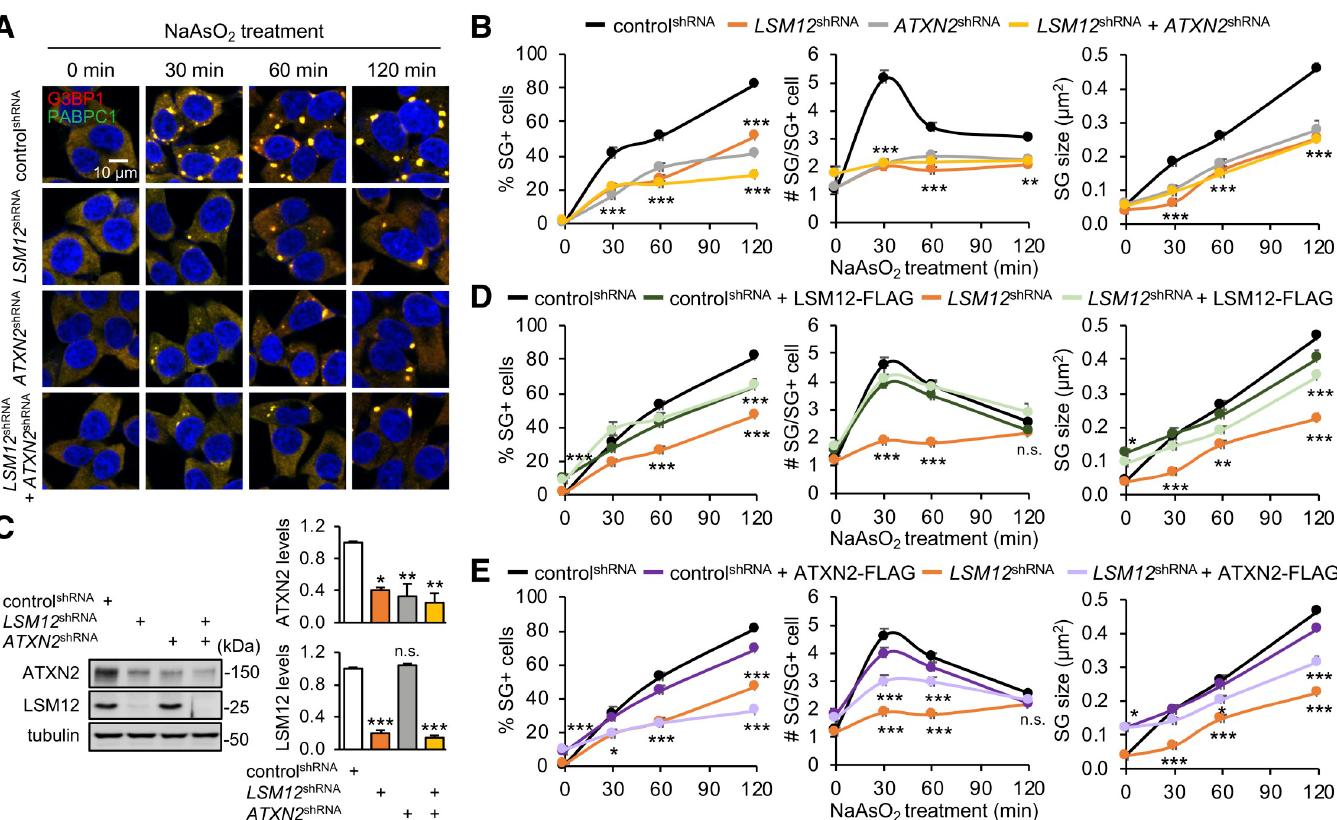
Fig 1. LSM12 depletion attenuates SG formation upon arsenite-induced oxidative stress. (A) LSM12 and ATXN2 promote arsenite-induced SG assembly, likely via the same genetic pathway. SH-SY5Y cells stably expressing each shRNA were incubated with 50- μ M sodium arsenite (NaAsO 2 ) for the indicated time and then co-stained with anti-G3BP1 antibody (red), anti-PABPC1 antibody (green), and Hoechst 33258 (blue) to visualize SGs and the nucleus, respectively. (B) The percentage of SG- positive cells, the number of SGs per SG-positive cell, and the size of SGs were quantified using ImageJ software and averaged ( n = 15–19 confocal images of random fields of interest obtained from 3 independent experiments; n = 329–1,045 cells). Error bars indicate SEM. �� P < 0.01, ��� P < 0.001 to control shRNA cells at a given time point, as determined by 2-way ANOVA with Tukey post hoc test. (C) Immunoblotting of total cell extracts from individual shRNA cell lines with anti-ATXN2, anti-LSM12, and anti-tubulin (loading control) antibodies. The abundance of each protein was quantified using ImageJ and normalized to that of tubulin. Relative protein levels were then calculated by normalizing to those in control shRNA cells. Data represent means ± SEM ( n = 3). n.s., not significant; � P < 0.05, �� P < 0.01, ��� P < 0.001, as determined by 2-way ANOVA with Tukey post hoc test. (D, E) Overexpression of LSM12, but not ATXN2, restores arsenite-induced SG assembly in LSM12-depleted cells. Control shRNA and LSM12 shRNA cells were transfected with an expression vector for FLAG, FLAG-tagged LSM12, or FLAG-tagged ATXN2. Arsenite-induced SG assembly was quantified 48 hours after transfection. Data represent means ± SEM ( n = 15–16 confocal images obtained from 3 independent experiments; n = 200–820 cells). n.s., not significant; � P < 0.05, �� P < 0.01, ��� P < 0.001 to control shRNA cells expressing FLAG at a given time point, as determined by 2-way ANOVA with Tukey post hoc test. All underlying numerical values are available in S1 Data. ANOVA, analysis of variance; ATXN2, ataxin-2; LSM12, like-Sm protein 12; SEM, standard error of the mean; SG, stress granule; shRNA, short hairpin.